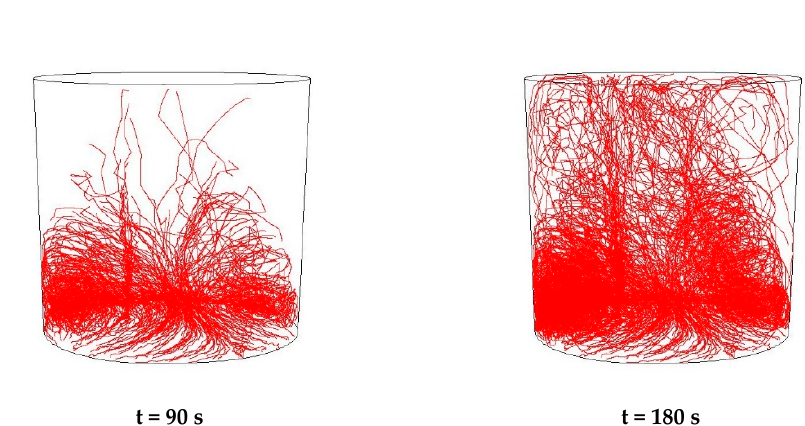
Figure 11. Trajectories of non-metallic Al 2 O 3 inclusions for the case of argon flow of 25 L/min for the particle diameters of ( a ) 18 µ m and ( b ) 27 µ m in the 42CrMo4 steel.